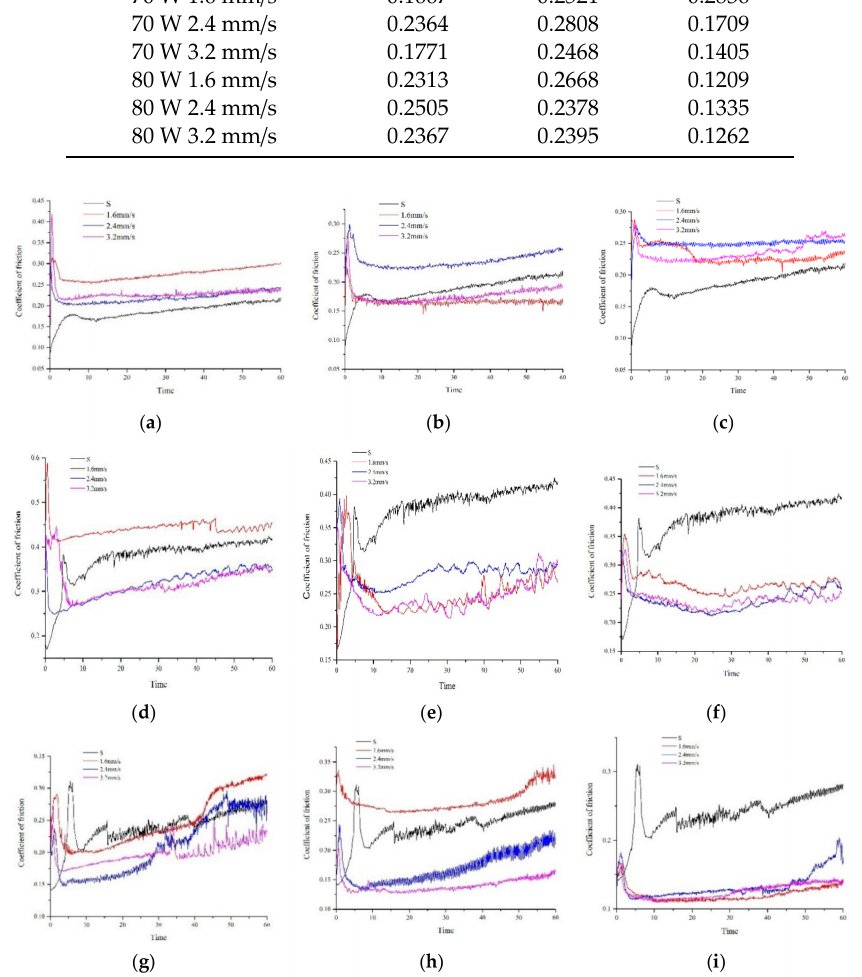
Figure 17. Curves of the friction coe ffi cient of di ff erent pruners over time under di ff erent loads: 300 g-load ( a ) laser power 60 W, ( b ) laser power 70 W, ( c ) laser power 80 W; 1100 g-load ( d ) laser power 60 W, ( e ) laser power 70 W, ( f ) laser power 70 W; 2000 g-load ( g ) laser power 60 W, ( h ) laser power 70 W, ( i ) laser power 80